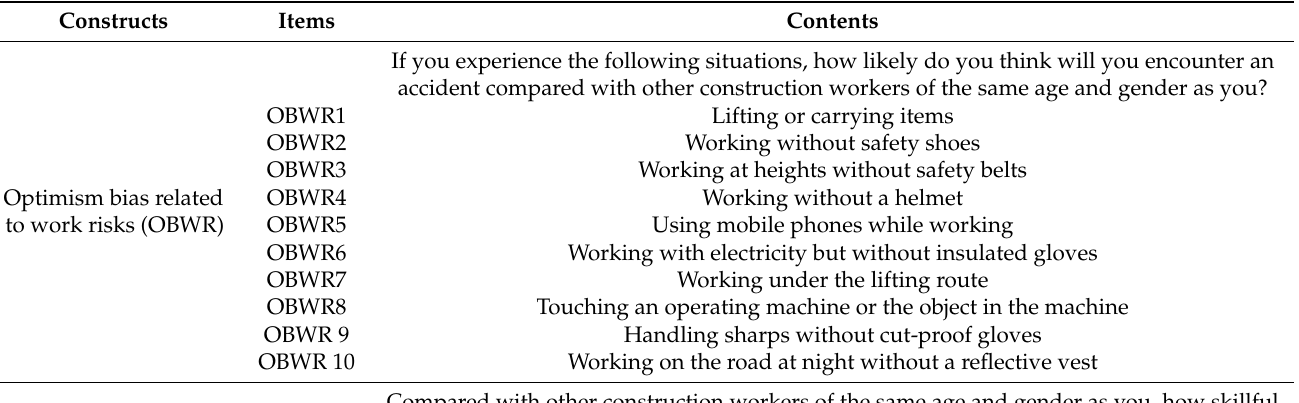
Table 1. Item contents of the